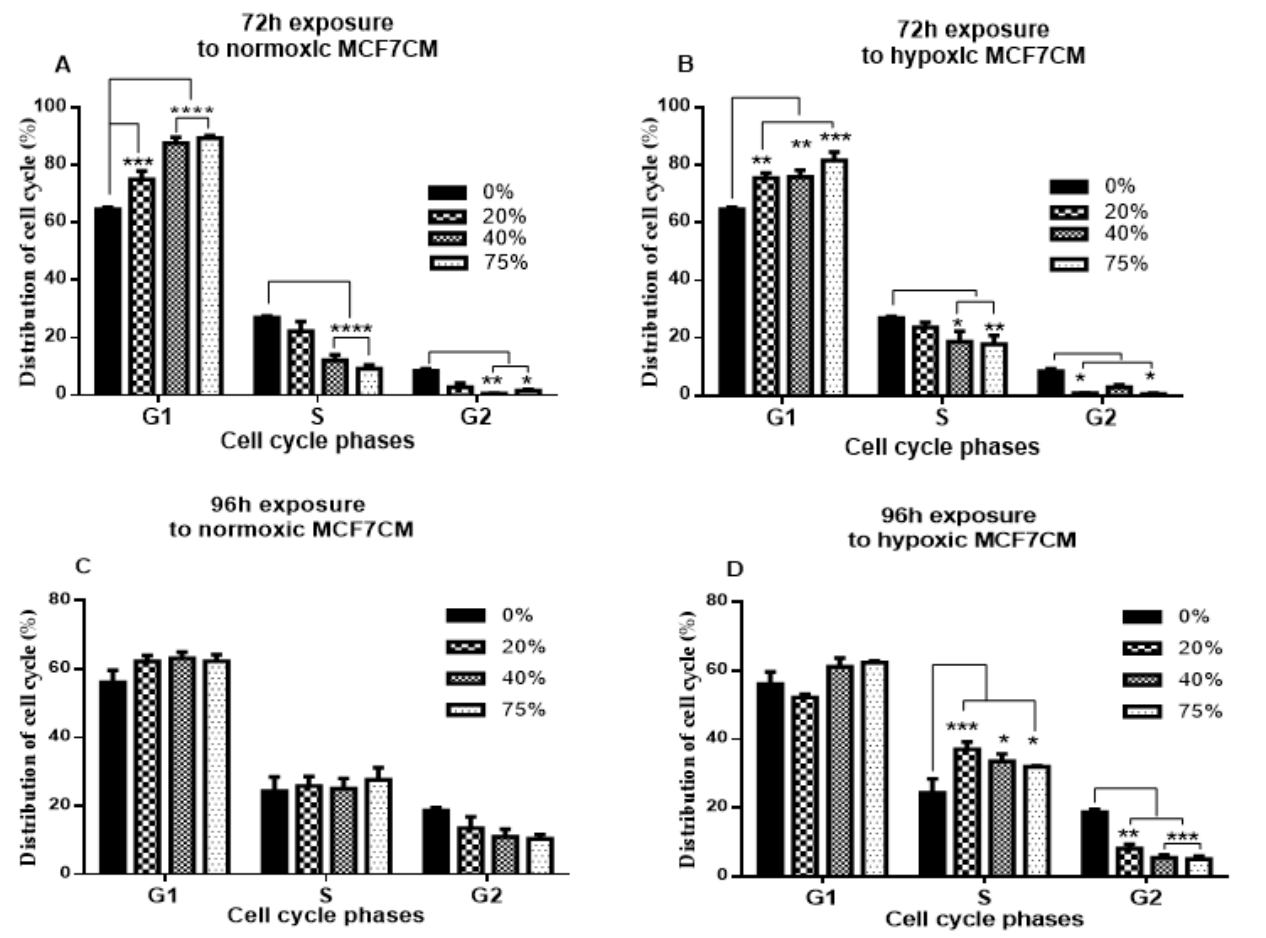
Figure 2. Represents a quantification of cell cycle distribution in bEnd.3 cells after exposure to conditioned media generated from MCF7 cells (MCF7CM) under normoxic (21% O 2 ) and hypoxic (5% O 2 ) conditions: ( A ) bEnd.3 cells were exposed to normoxic MCF7CM for 72 h. ( B ) bEnd.3 cells were exposed to hypoxic MCF7CM for 72 h. ( C ) bEnd.3 cells were exposed to normoxic MCF7CM for 96 h. ( D ) bEnd.3 cells were exposed to hypoxic MCF7CM for 96 h. (* p < 0.05, ** p < 0,01, *** p < 0.001, **** p < 0.0001 ; n = 3).